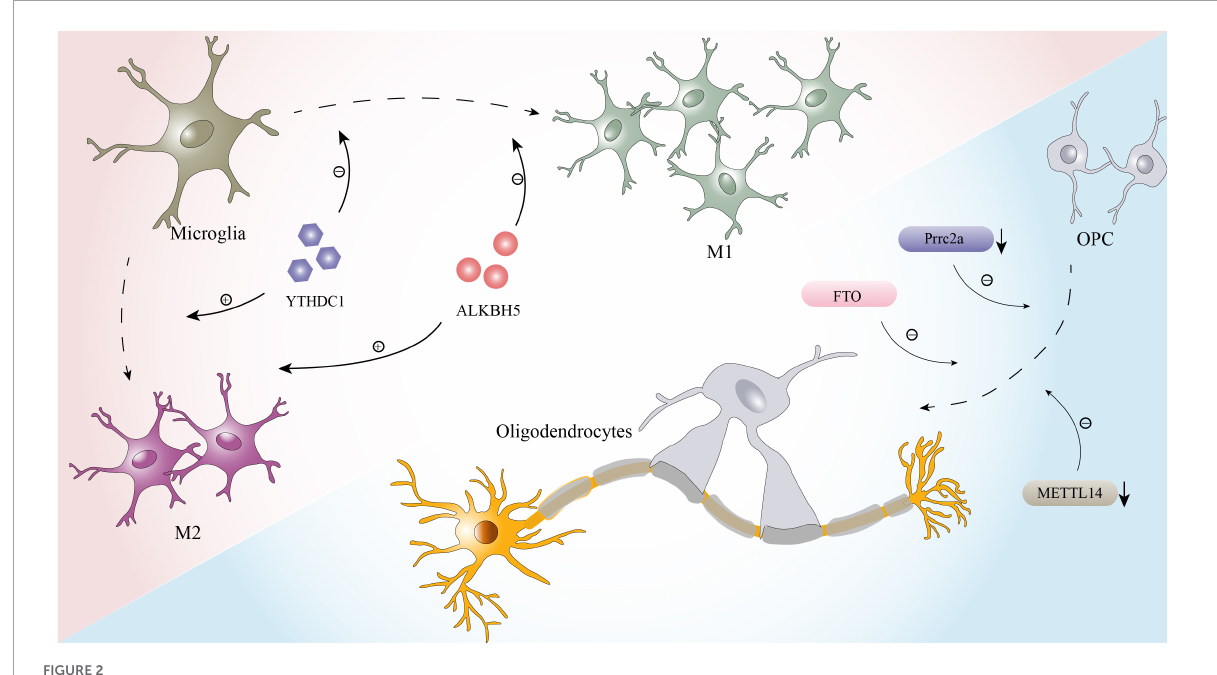
FIGURE2 The effects of m6A on microglia and